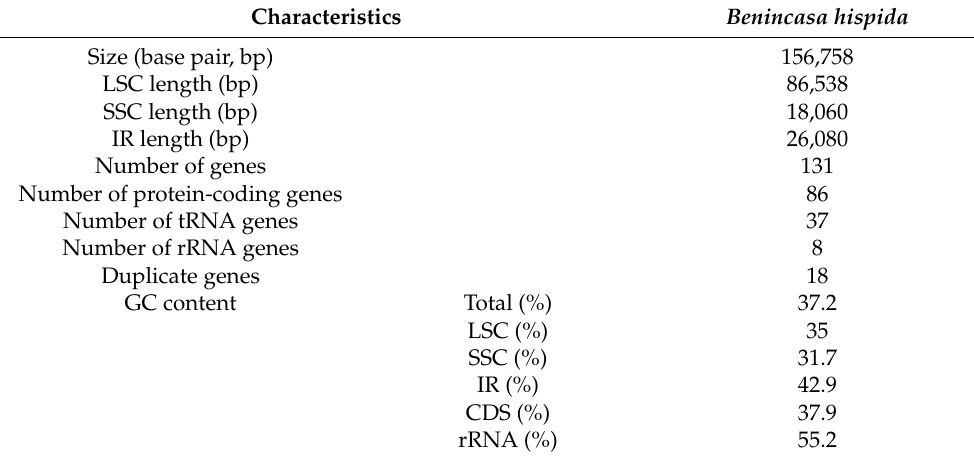
Table 1. Chloroplast genome general features of Benincasa hispida